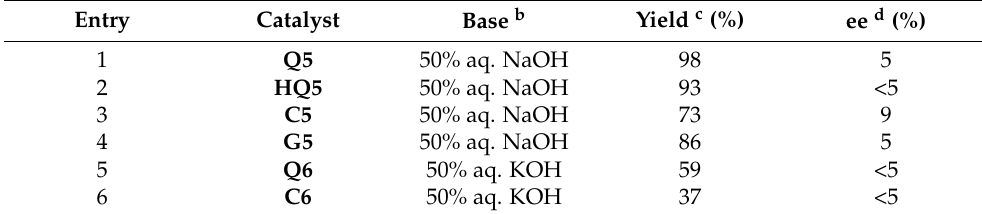
Table 1. Comparison of the catalysts in the α -alkylation of malonate 1 a .